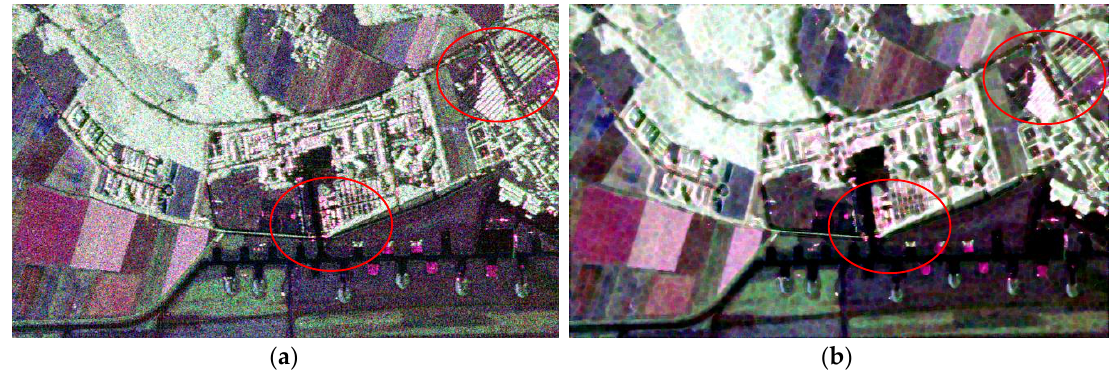
Figure 2. Pauli-RGB images of the Experimental Synthetic Aperture Radar (ESAR) PolSAR data: ( a ) Original image and ( b ) 7 × 7 refined Lee filtered image.